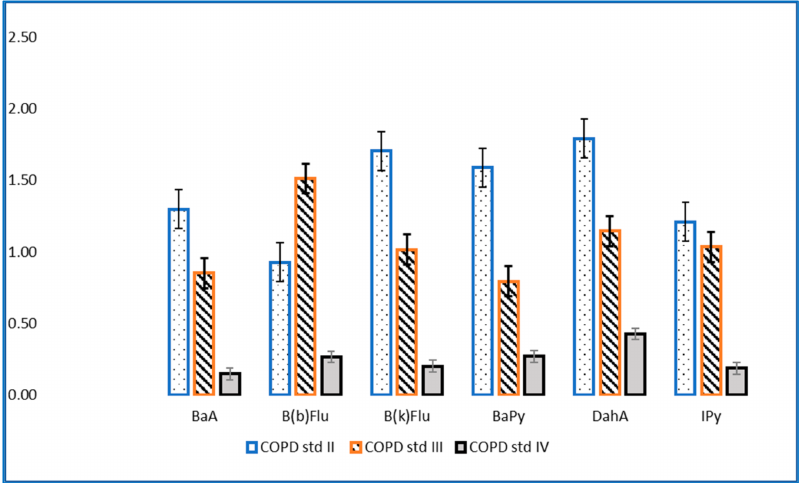
Figure 1. Levels of carcinogenic PAHs (ng/mL) in patients with stage II, III and IV COPD.